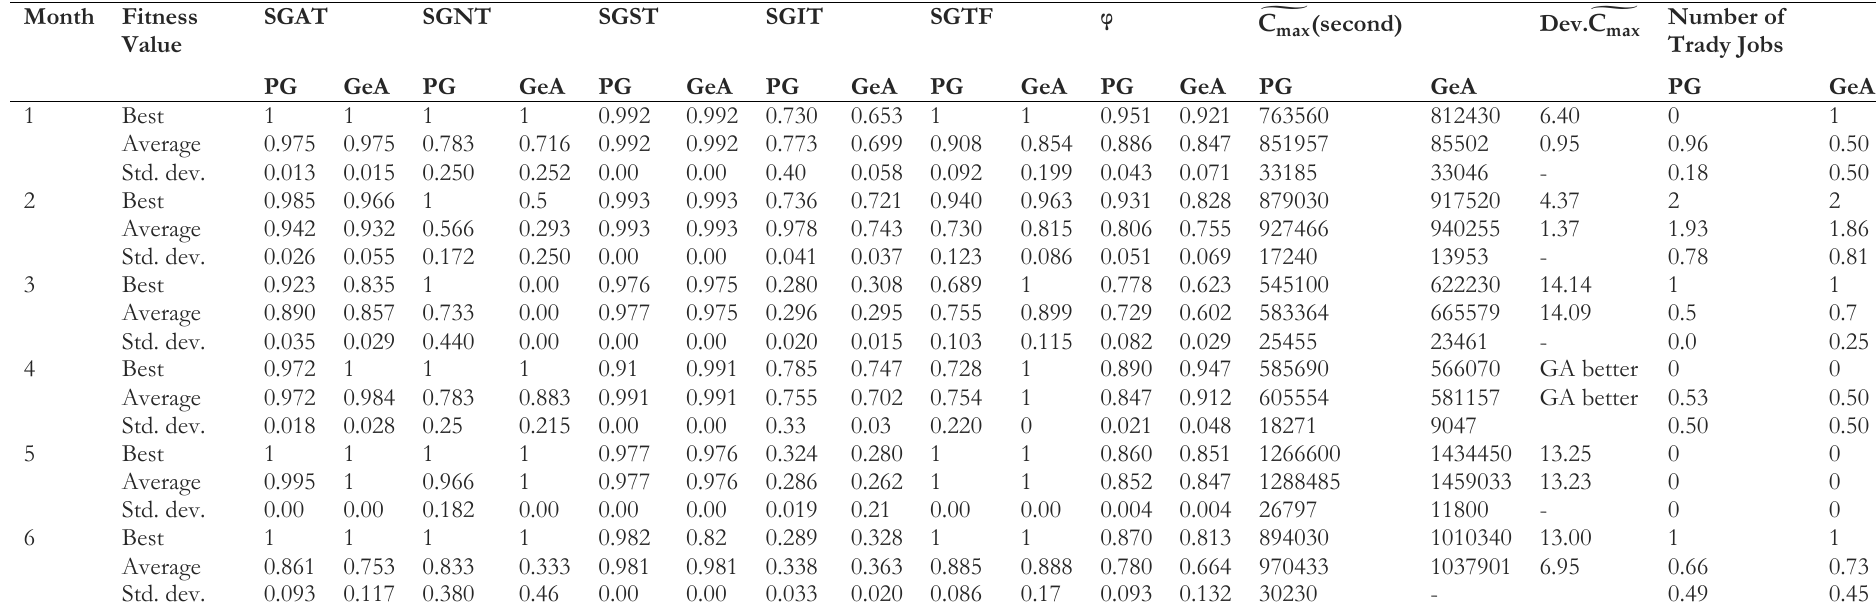
Table 5. Fitness values of the aggregated SG and